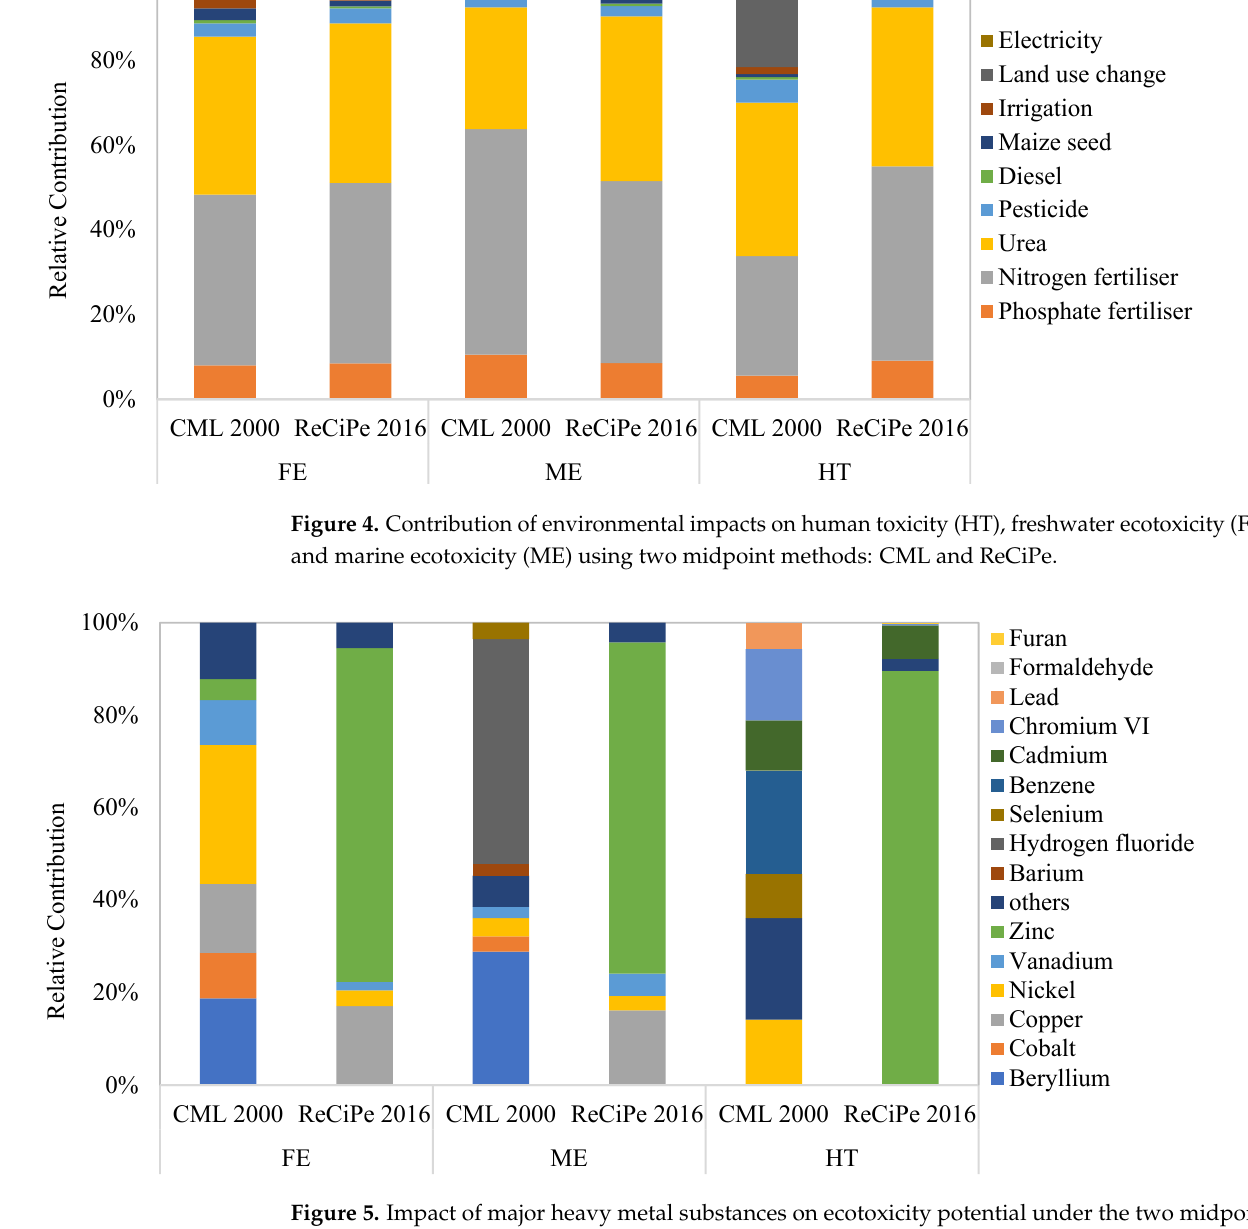
Figure 5. Impact of major heavy metal substances on ecotoxicity potential under the two midpoint methods: CML and ReCiPe.